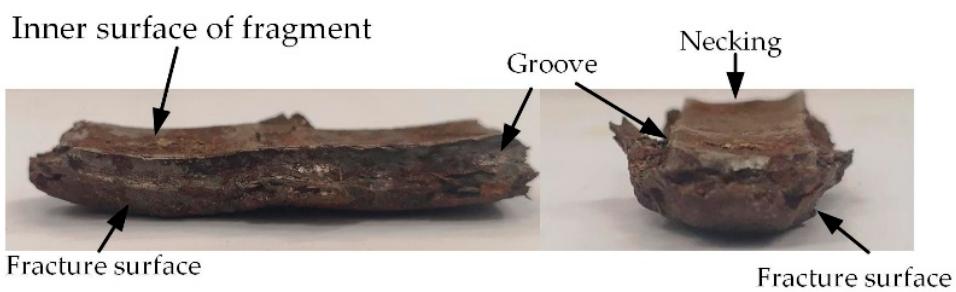
Figure 20. Necking and fracture surface of the recovered fragment.